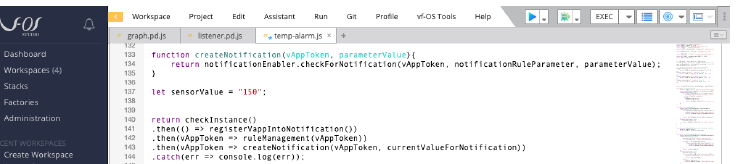
Figure 10. Example of the execution of a service using EF; in particular, sending a notification based on a sensor